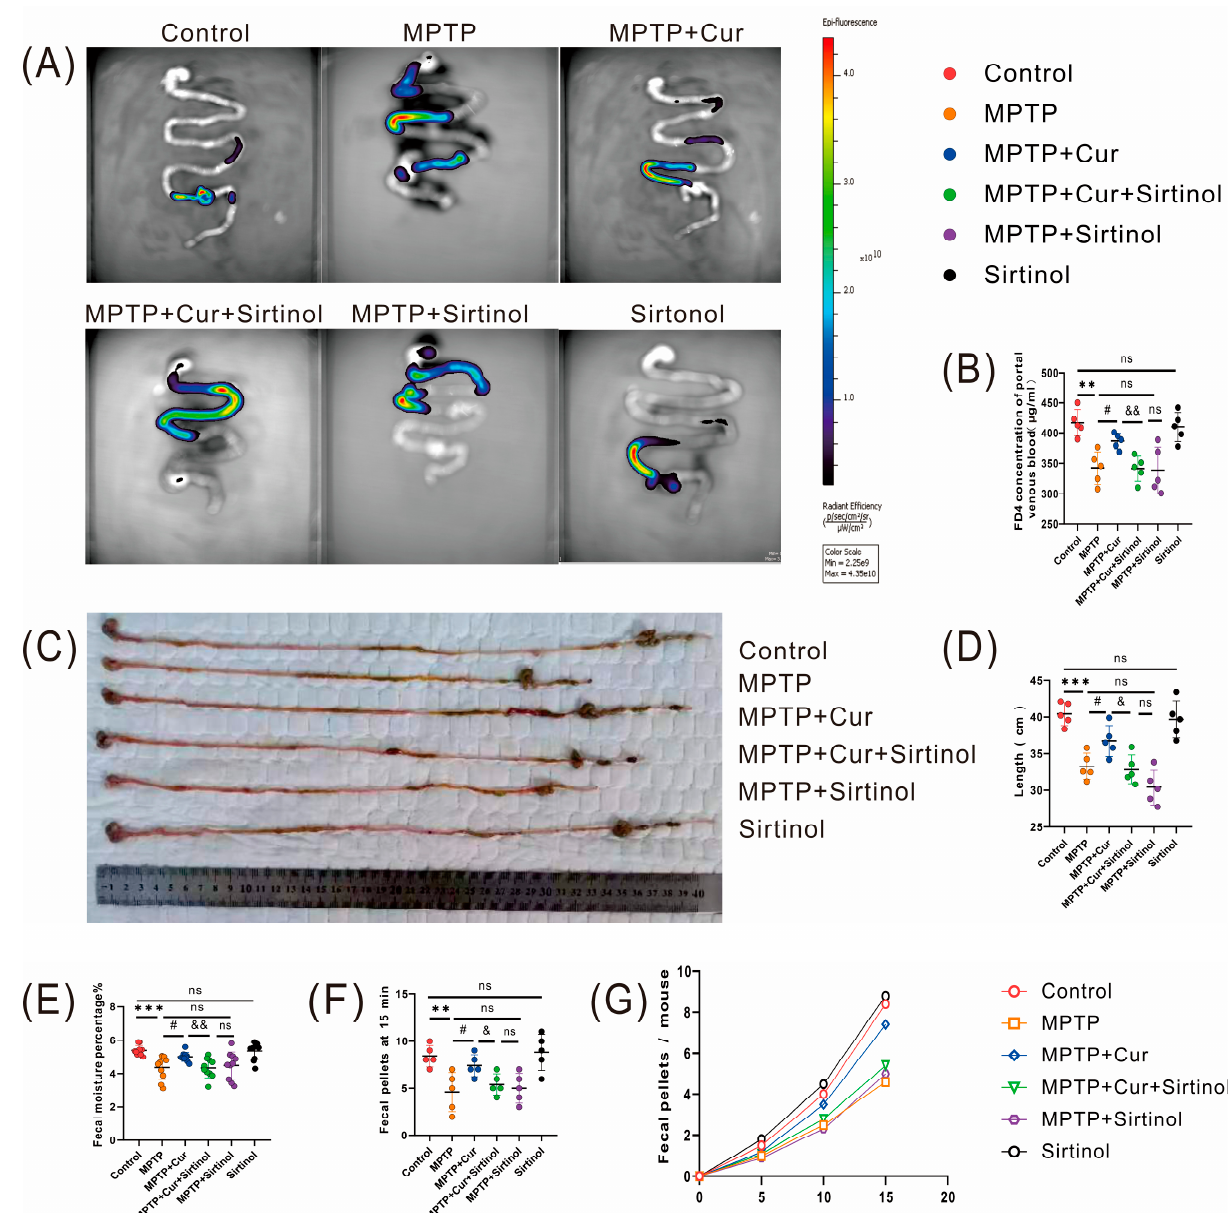
Figure 7. Curcumin ameliorated gastrointestinal dysfunction by reducing intestinal inflammation in MPTP-induced mice. ( A , B ) Intestinal motility test ( n = 5/group): ( A ) representative image, ( B ) concentration of isothiocyanate–dextran in portal venous blood; ( C , D ) full-field anatomical images of mouse gastrointestinal tract ( n = 5/group); ( E ) fecal water content ( n = 10 groups); ( F , G ) number of 15 min fecal pellets in mice;All statistical differences were tested using the t -test using ( B , D – F ). Data are expressed as the mean ± SEM ( n = 5/group). Representative results are for one of the independent experiments. ** p < 0.01and *** p < 0.001 vs. control group. # p < 0.05 vs. MPTP group. & p < 0.05 and && p < 0.01 vs. MPTP + Cur group. n.s., not significant.